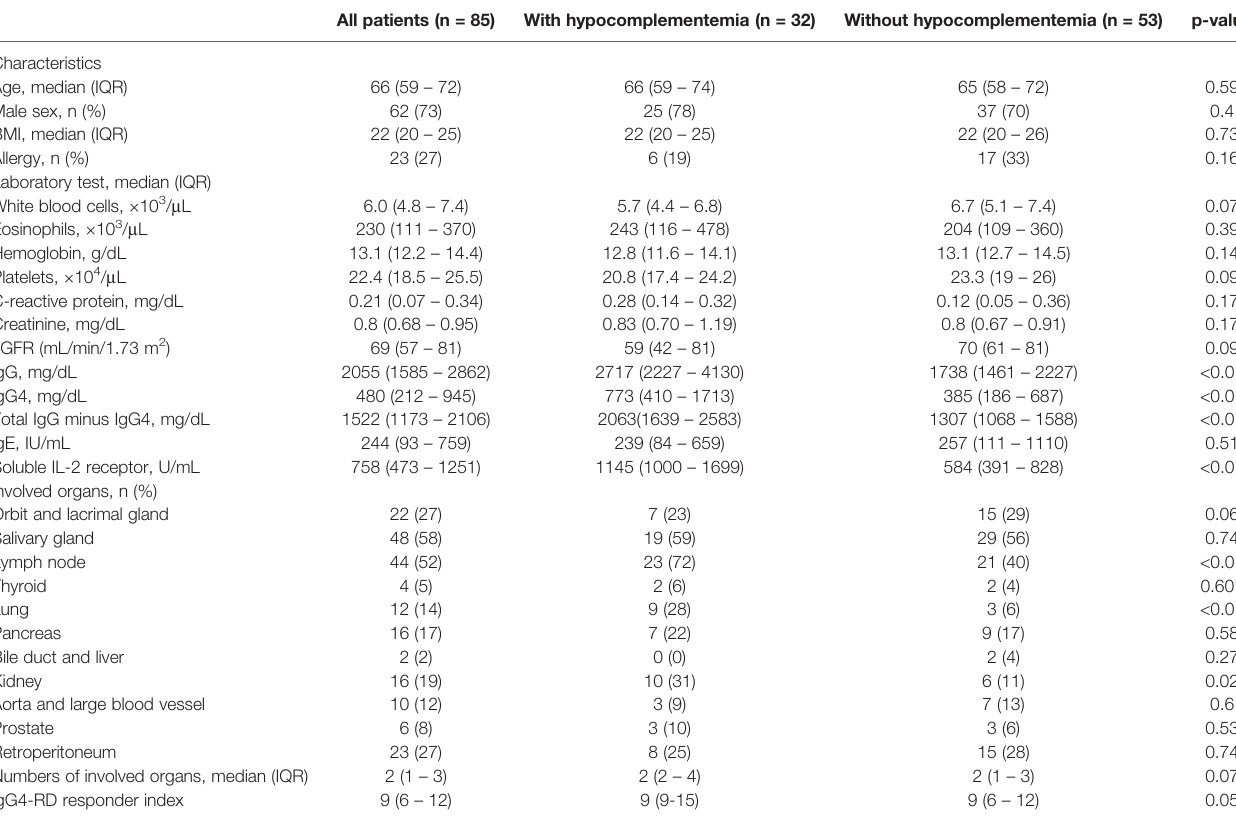
TABLE 1 | Demographic, clinical, and laboratory characteristics of patients with immunoglobulin 4-related disease diagnosed with or without